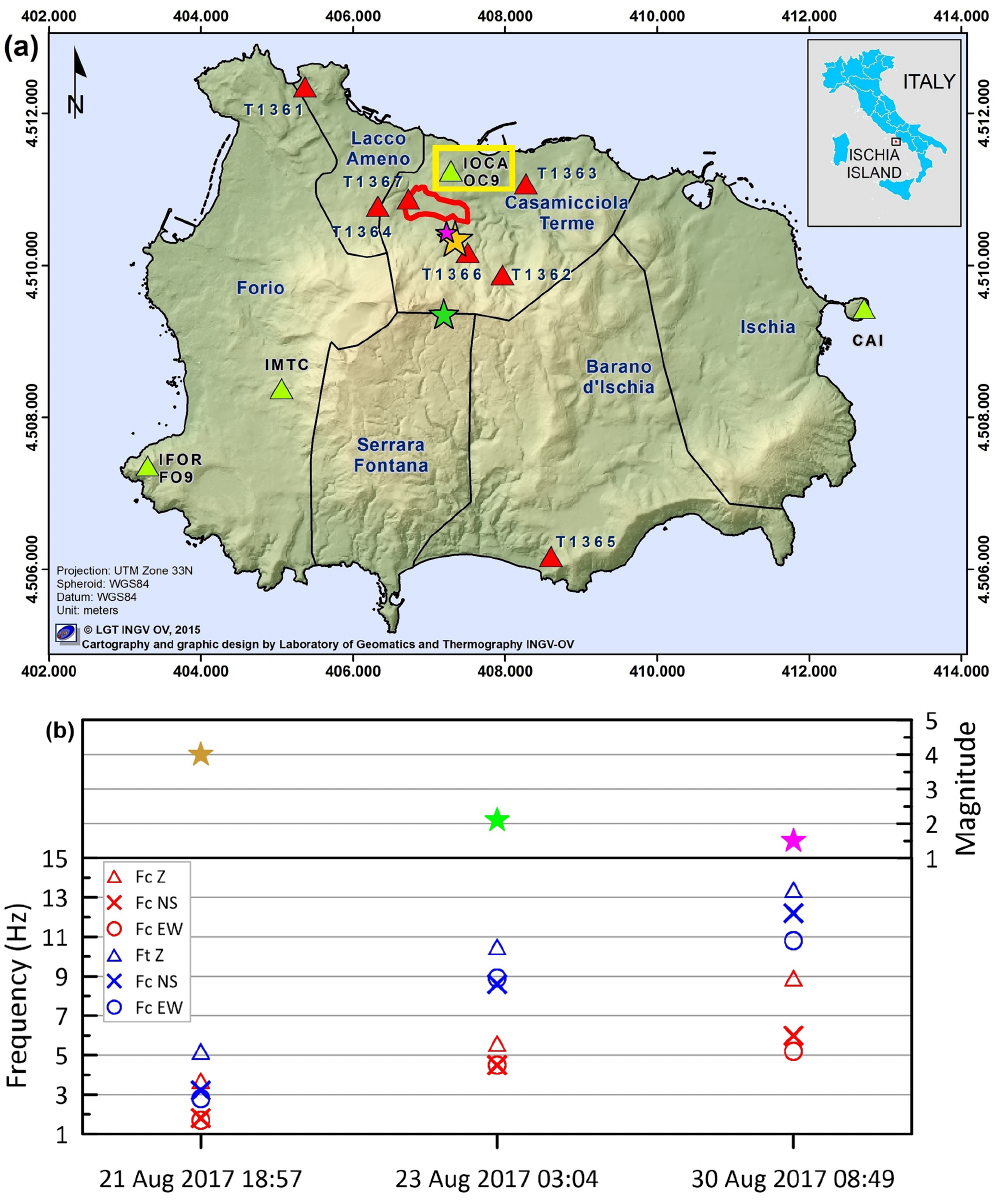
Figure 1. (a) Map of Ischia Island. Permanent (green triangles) and Mobile (red triangles) Seismic Networks (for technical details see Moretti et al., 2016; D’Auria et al., 2018; Galluzzo et al., 2019). The yellow box indicates the reference station, IOCA, used for the present analyses. The location of the IE17 and of the two major aftershocks is marked by a golden, a green and a magenta star, respectively, whose dimension is proportional to magnitude. The red line delimits the area most struck by the IE17; (b) Values of corner frequency ( F c ) and frequency threshold ( F t ) below which the 95% of the cumulative energy is released, obtained from the spectral analysis of the three earthquakes recorded at the three-component IOCA station. The duration magnitude M d is reported in the upper part of panel (b)